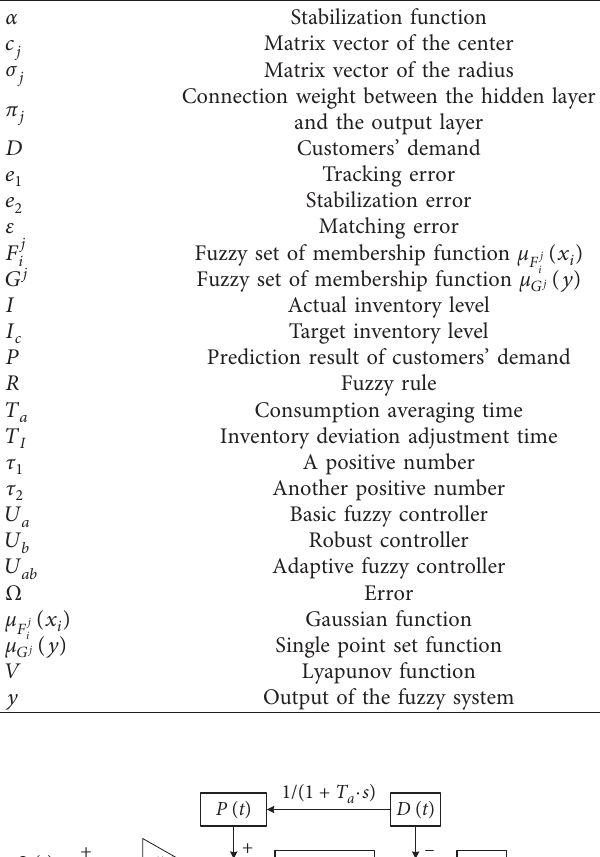
Table 1: Meanings of relevant symbols.